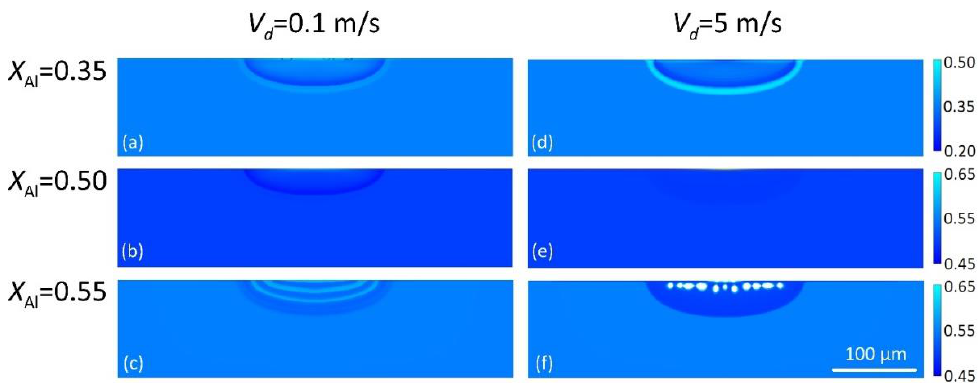
Figure 3. Final 2D distribution of Al concentration after laser surface melting, calculated for three compositions— x Al = 0.35 ( a , d ), 0.5 ( b , e ), 0.55 ( c , f )—considering two different values of the diffusive speed—0.1 m/s ( a – c ), 5 m/s ( d – f ). The white spots in ( f ), indicate regions with a concentration greater than the upper limit of the display range (i.e., x Al > 0.65).